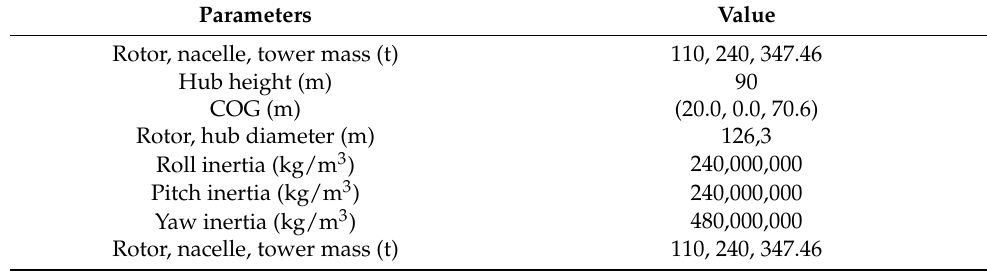
Figure 4. Conceptual diagram of the barge-type FOWT with aquaculture cage.